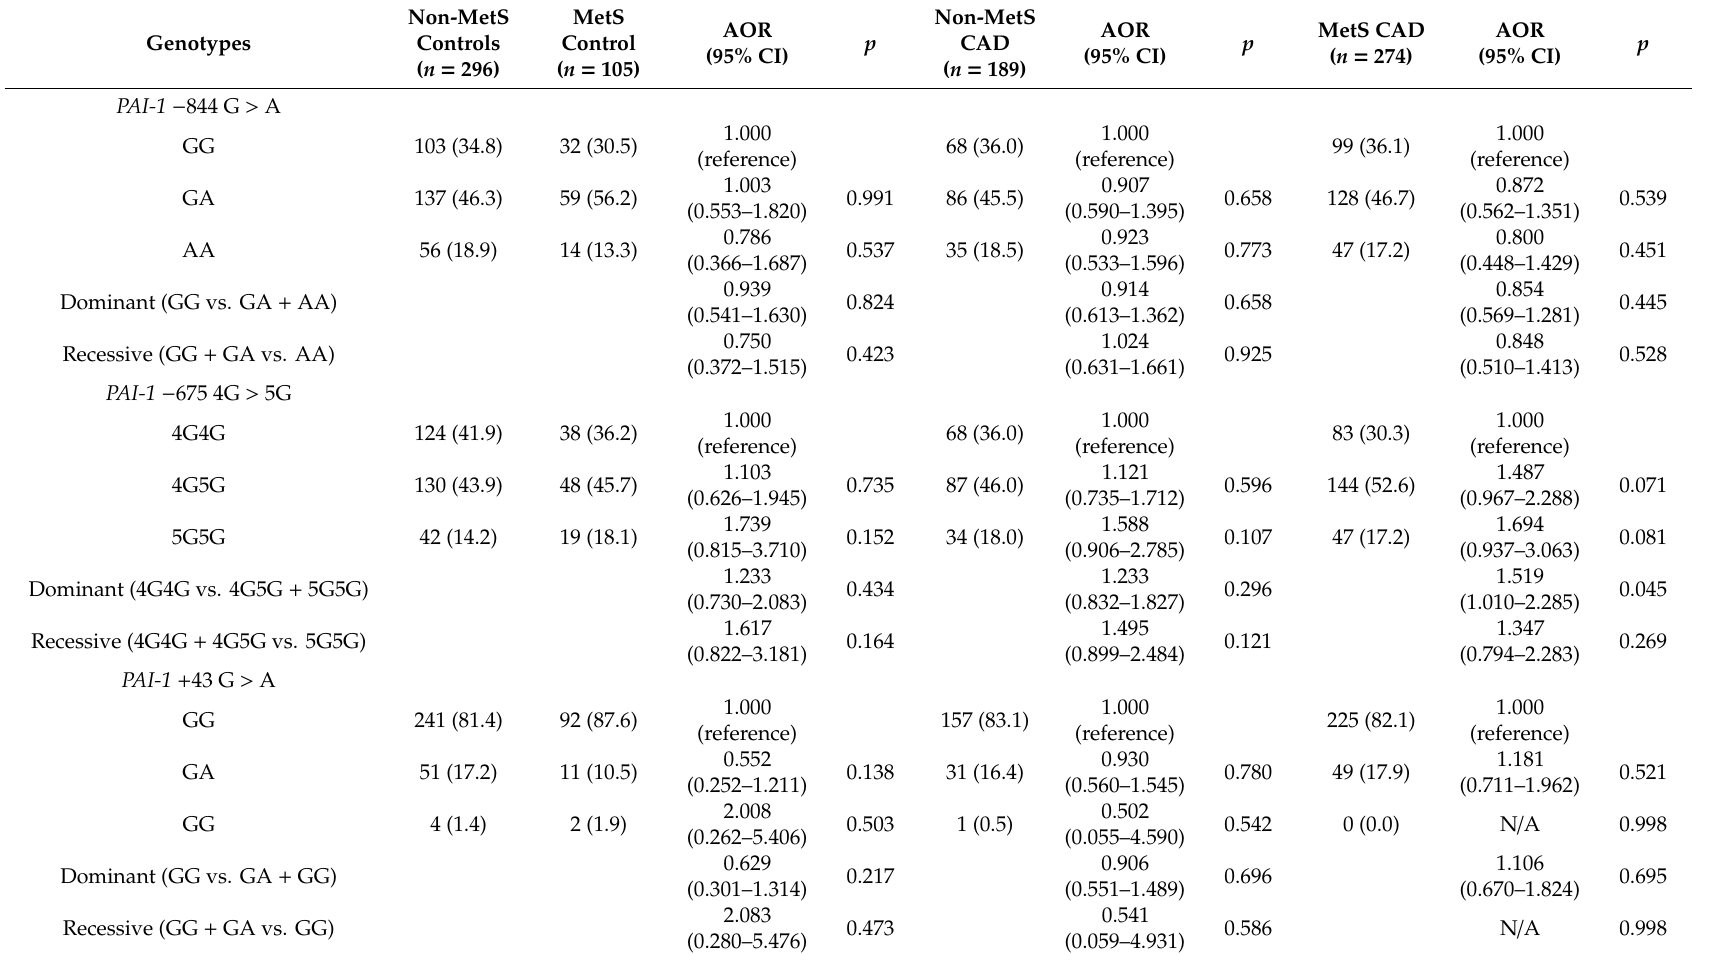
Table 3. Genotype frequencies of PAI-1 polymorphisms according to metabolic syndrome